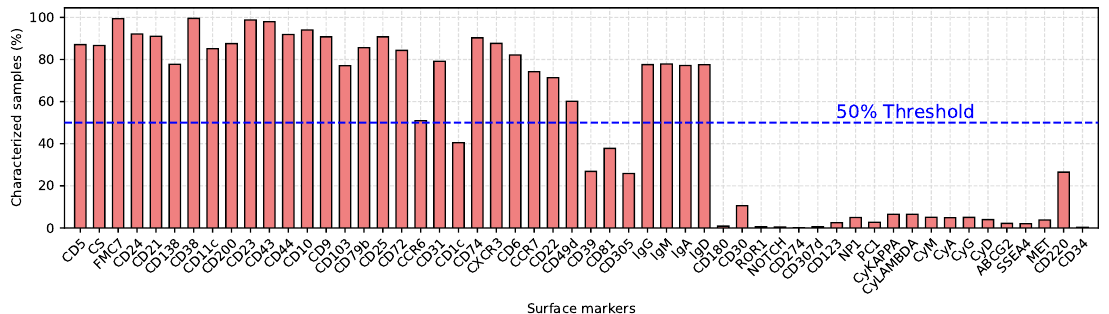
Figure 5. List of surface markers associated with the percentage of samples characterized for each marker. The blue dotted line indicates the threshold (50%) above which markers were